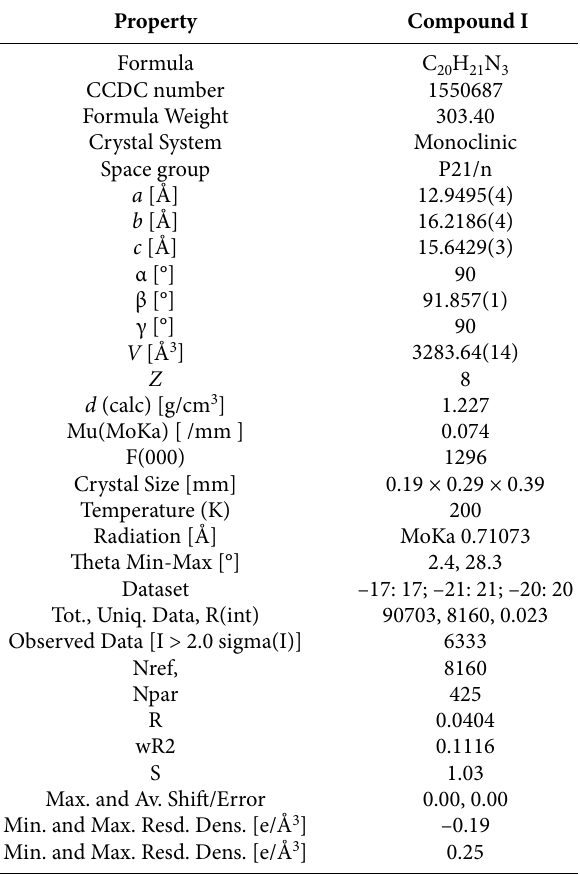
Table 1. Crystallographic data and structure refinement summary for compound I